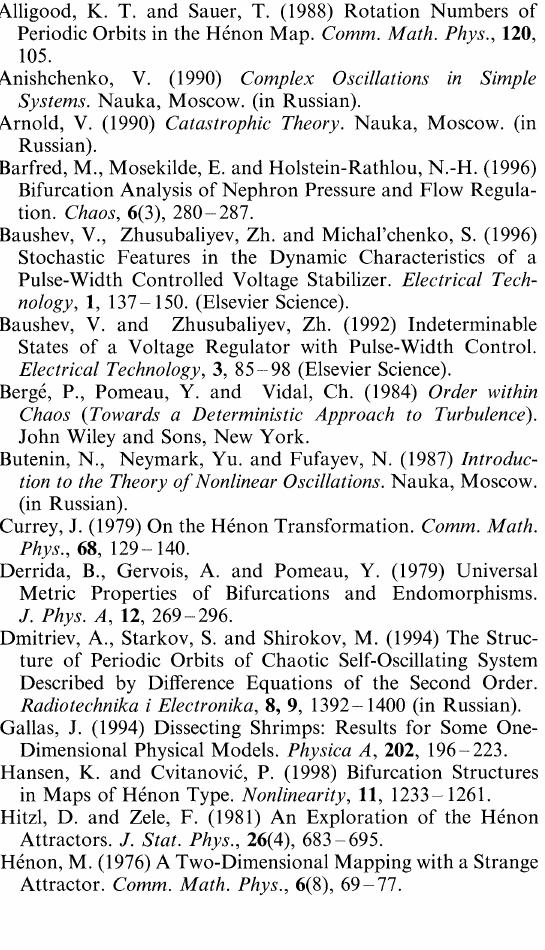
FIGURE 19 The qualitative plot of the variation of the stable and unstable 5-cycles with the parameters when the trajectory of deformation passes through the bifurcation point 0 TM of codimension 2. S_ x (P) and xS+(P) correspond to the stable